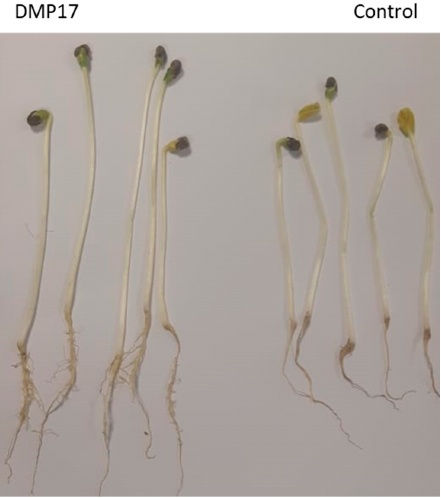
Figure 4. Effect of DPM17 on okra plant